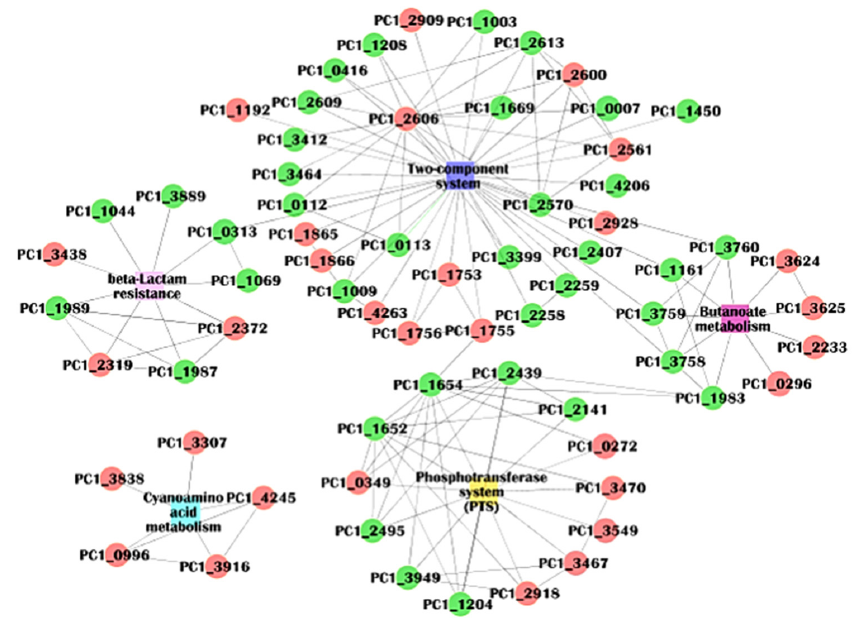
Figure 8. Protein–protein interactions analysis for DEPs and their pathways. Green node indicates a downregulated protein, and red means an upregulated one.